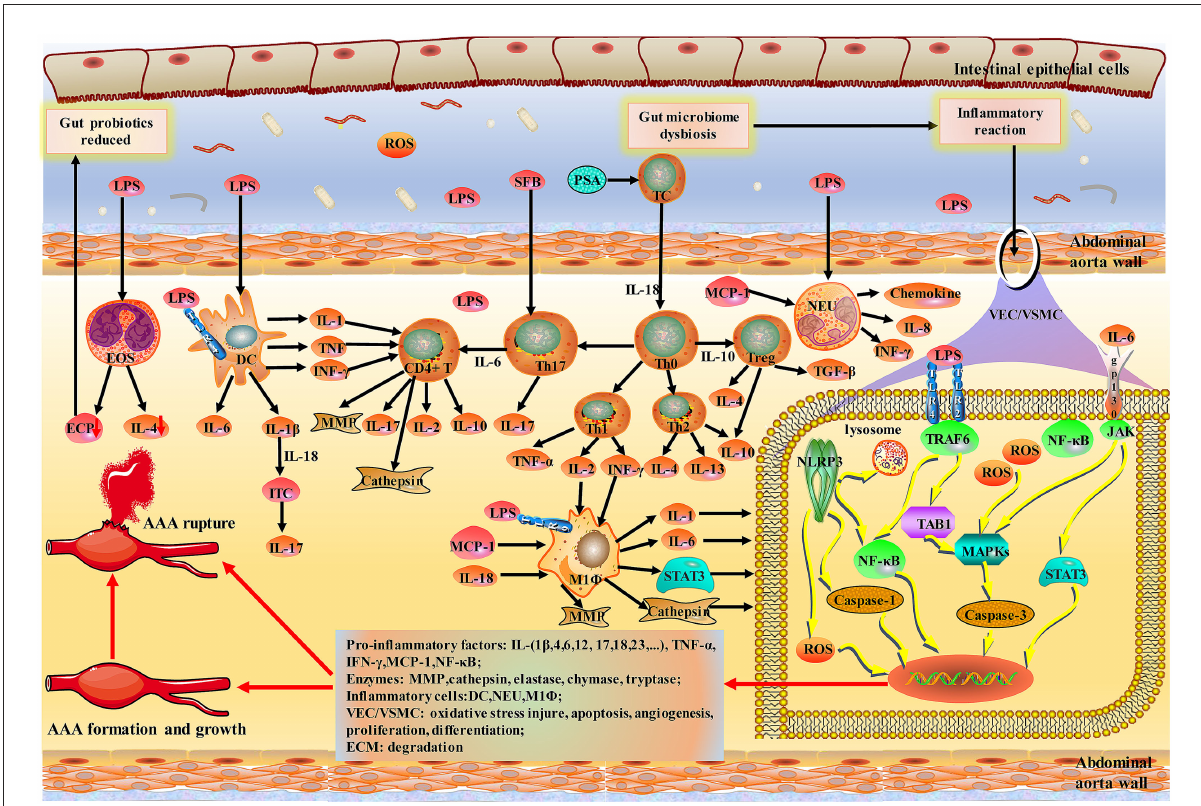
FIGURE3 Schematic of indirect damage to AAA caused by inflammatory response to the gut-aortic axis. Bacteroides fragilis PSA has been shown to impact Th1/Th2 ratio. NLRP3 inflammasomes, members of the NOD-like receptor (NLRs) family, are widely present in vascular endothelial cells and various immune cells. Activation of TLR and NLRP3 inflammasomes during initial immunity can exacerbate vascular wall damage through caspase-mediated apoptosis. MCs, M 8 , and NEU are activated by LPS and then release a variety of pro-inflammatory factors. EOS upregulation of IL4 regulates the polarization of M 8 and monocytes and blocks NF- κ B activation in aortic inflammation and vascular wall cells. Notably, IL-6 can chemotact monocytes/macrophages and activate STAT3 and MCP-1 to promote the expansion of the abdominal aorta. Various inflammatory factors and enzymes lead to the formation, growth and rupture of AAA. PSA, polysaccharide A; NLR, NOD-like receptor; TLRs, toll-like receptors.